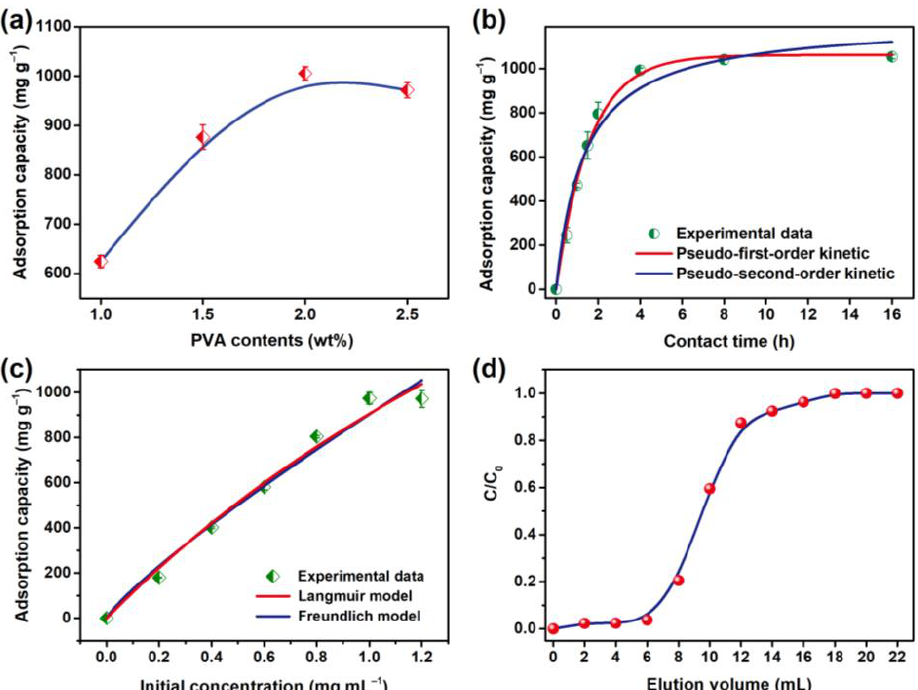
Figure 6. ( a ) Protein adsorption capacities of the NHMs with various PVA contents. Experimental results and the resultant fitting curves related to the ( b ) adsorption isotherm and ( c ) kinetics adsorption curves of CCA-co-PVA/SiO 2 NFMs with 2 wt% PVA. ( d ) The obtained breakthrough curve of NHMs (3 layers, total thickness of around 0.2 mm). Table 1. The relevant kinetic parameters of lysozyme adsorption on the NHMs.